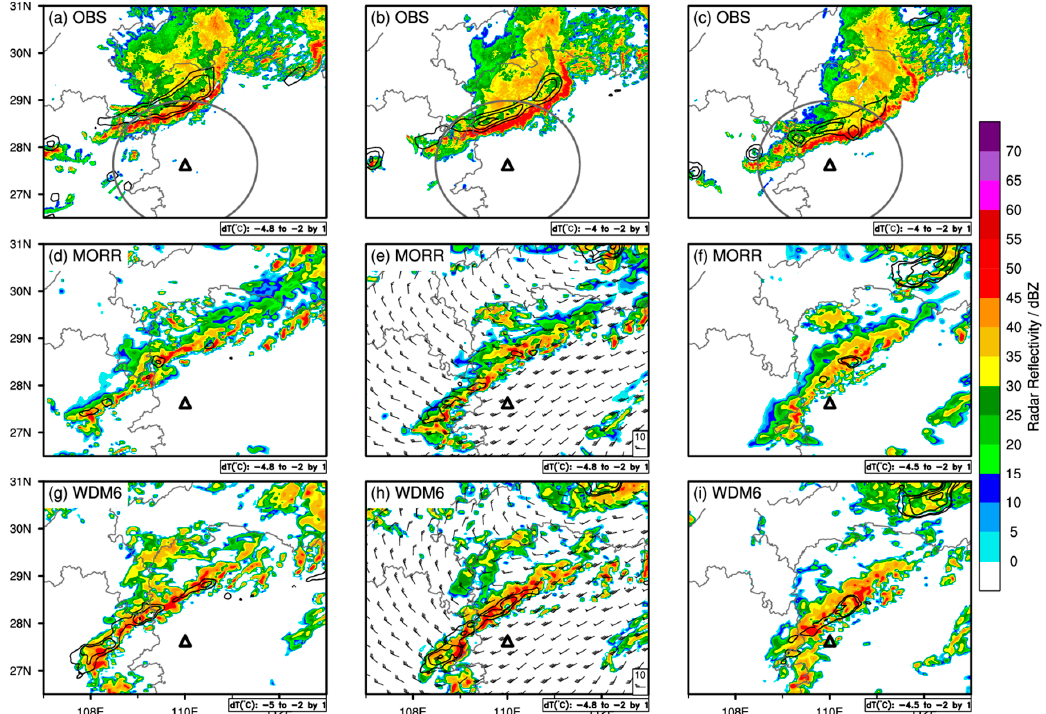
Figure 6. Temporal evolution of observed and simulated radar reflectivities (dBZ) for the 16 March 2022 squall line case at 1200 UTC (left column), 1300 UTC (middle column), and 1400 UTC (right column) at an elevation of 3 km. Black contours show the hourly temperature change, indicating the location of the surface cold pool. The triangle in each panel indicates where S-POL is situated. The dark gray circles in the first three panels indicate the 150 km range from the radar.